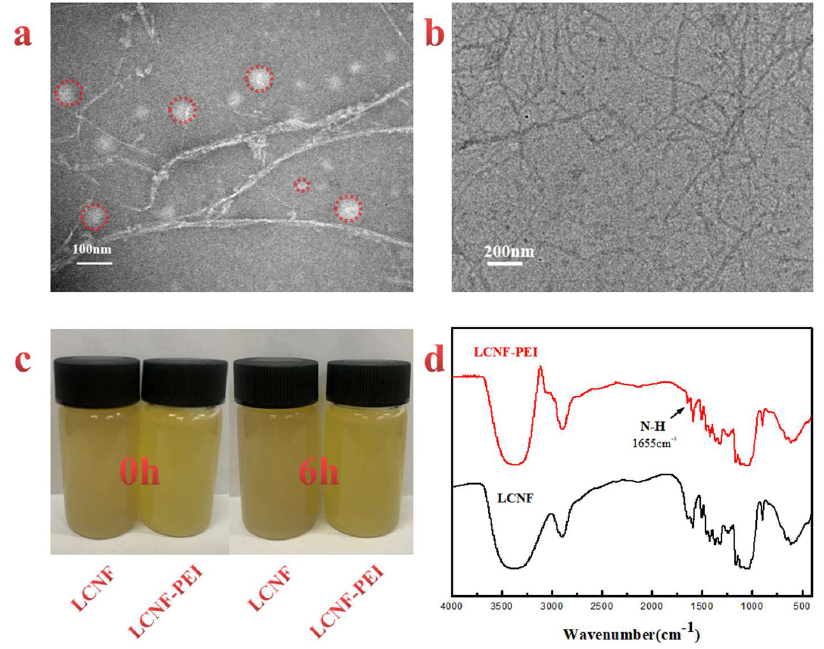
Figure 3. ( a ) The morphology of the LCNF suspension; ( b ) the morphology of the LCNF-PEI suspension; ( c ) digital camera images of LCNF and LCNF-PEI at different storage times; ( d ) the FTIR spectrum of the LCNF and LCNF-PEI.